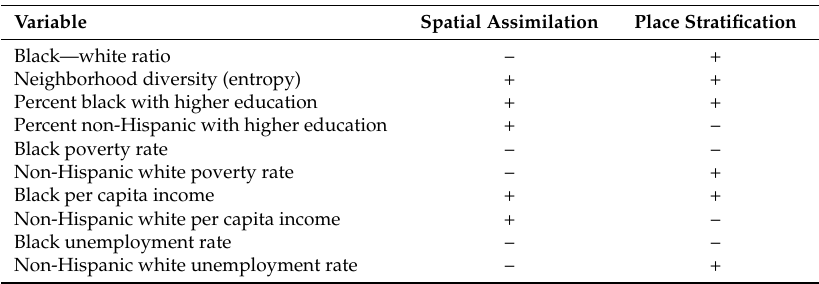
Table 1. Expected impact of key variables per theory of residential